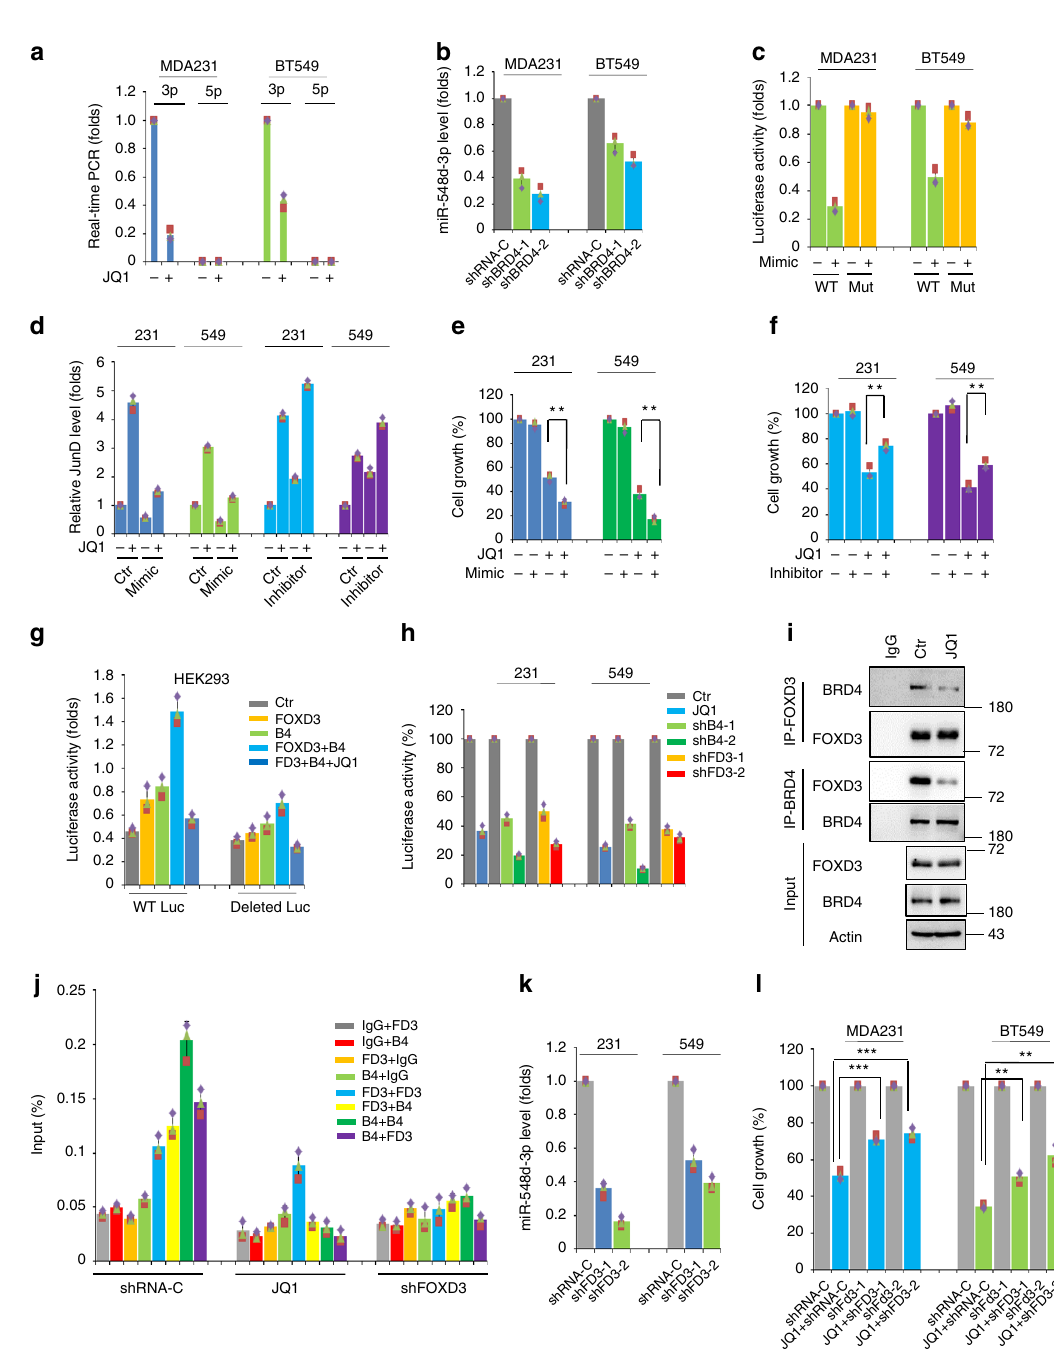
Fig. 3 JunD/RSK3 signalling correlates to BET inhibition sensitivity. a Correlation analyses of JUND and RPS6KA2 in four datasets of breast cancer patients from GEO. GSE76275 was separated into two sub-groups: triple-negative (TN) and non-triple-negative (non-TN); GSE43358 was separated into two sub-groups: triple-negative (TN) and non-triple-negative (non-TN); GSE42568 was separated into two sub-groups: ER-positive (ER + ) and ER-negative (ER − ); GSE31448 was separated into two sub-groups: luminal A (lumA) and luminal B (lumB). Pearson Coef fi cients of correlation and p values are shown. b Gene differential expression analyses of the mRNA levels of JUND and RPS6KA2 were conducted in two datasets that contained four subtypes of breast cancer patients, including BLBC, luminal A, luminal B and HER2 + . c The mRNA expression statuses of JUND and RPS6KA2 were detected in a panel of breast cancer cell lines by quantitative PCR assay. d Protein expression levels of JunD and RSK3 were detected in a panel of breast cancer cell lines by western blotting. e Luminal and HER2 + breast cancer cell lines as well as BLBC cell lines were treated with DMSO or JQ1 (1 μ M) for 48 h, cell growth was detected by CCK8 assay. Statistical data (mean ± SD) are shown. f RPS6KA2 and JUND genes were knocked down in two JQ1-resistant breast cancer cell lines, cell growth was measured by CCK8 assay. Statistical data (mean ± SD) are shown (*** P < 0.001, one-way ANOVA). Source data are provided as a Source Data fi